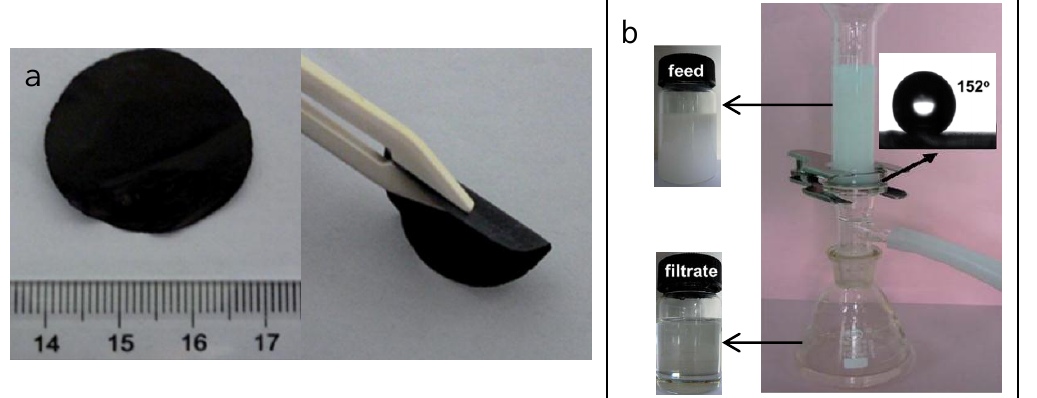
Figure 11. Oil-water separation for superhydrophobic CNTs-polystyrene composite membranes: photographs of ( a ) membranes and ( b ) oil-water separation [95].